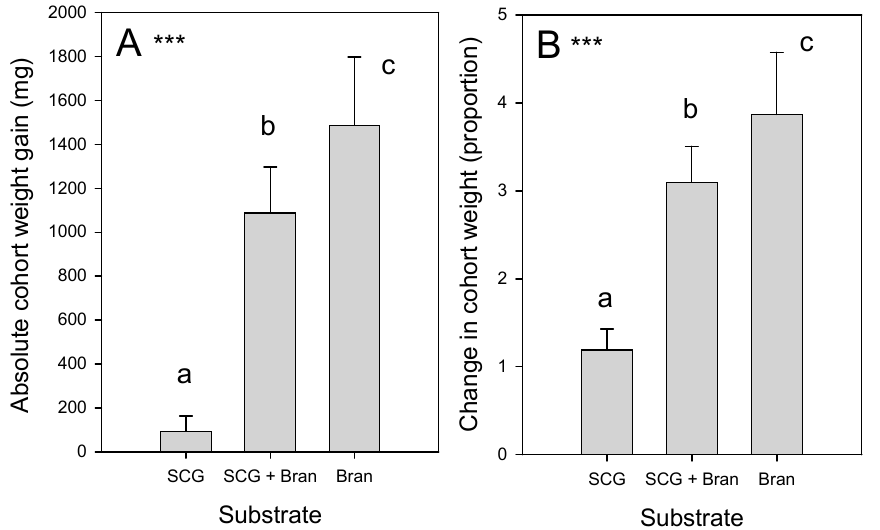
Figure 2. ( A ) Absolute weight gain of BSF larvae on three substrates supplied ad libitum during 12 days of feeding with ( B ) proportional changes in cohort weights (SCG = spent coffee grounds). Results of GLMs are indicated as *** = p < 0.001; lowercase letters indicate homogenous substrate groups (Tukey p > 0.05). Standard errors are indicated (N = 6). For further details see Table S1.